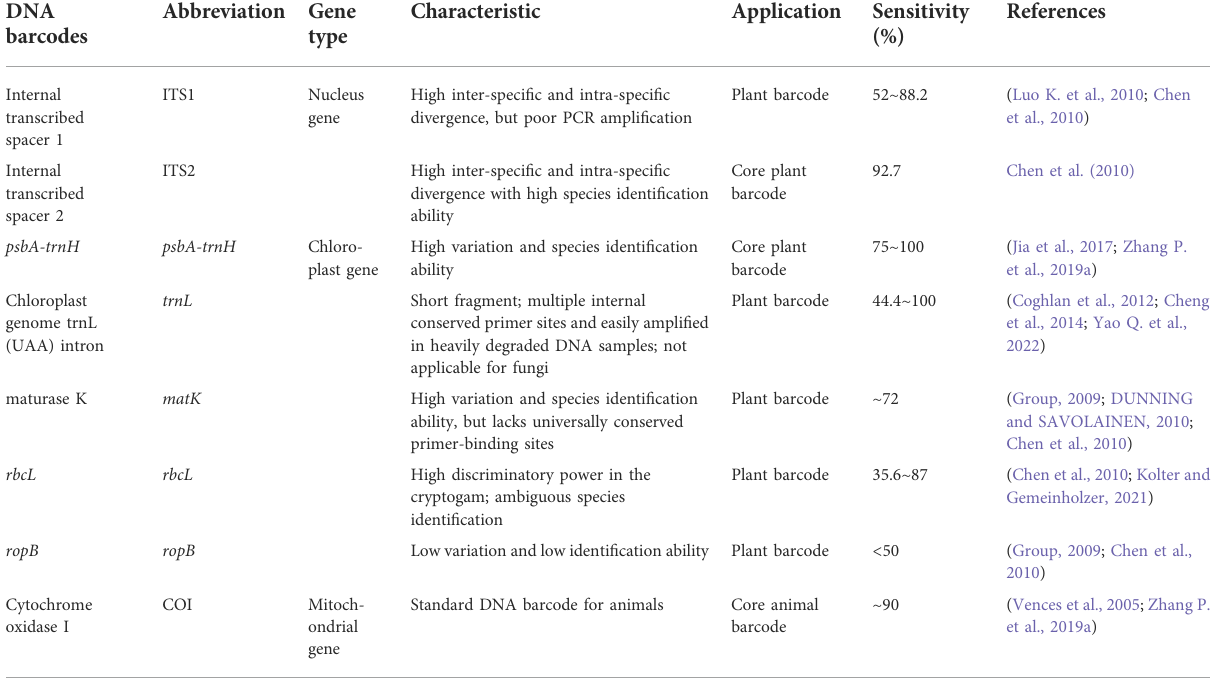
TABLE 1 The candidate DNA barcodes for identifying ingredients of TCM